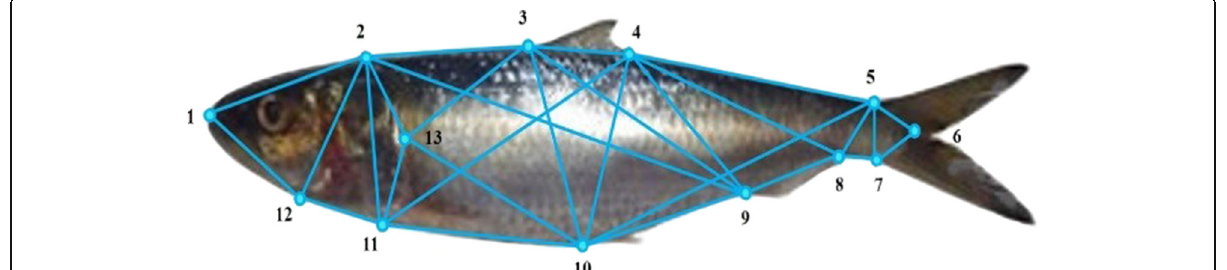
Fig. 2 Location of 13 landmarks and scheme of the truss network used in A. clupeoides morphometric